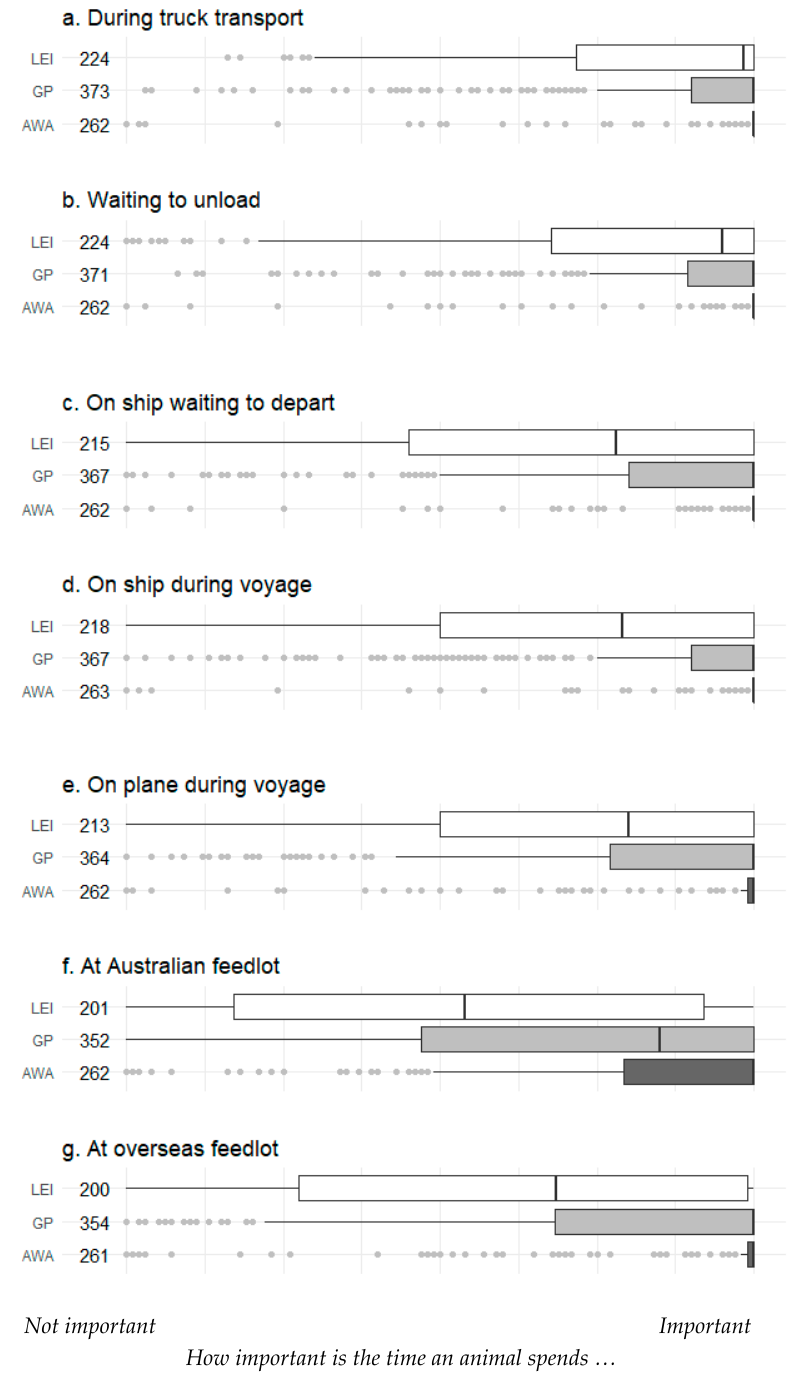
Figure 5. Rating of the importance of how much time an animal spends at each location by survey respondents grouped into three stakeholder categories: animal welfare advocates (AWAs), general public (GP) or live export industry (LEI) workers. Numbers next to stakeholder groups indicate the number of respondents for each question. Data were collected using a visual analogue scale: values are medians (vertical line) and quartiles (boxes) ± non-outlier range (whiskers); dots represent outliers (1.5 × the inter-quartile range). For all these questions, responses differed significantly between the three stakeholder groups (Kruskal–Wallis ANOVA; p < 0.001).